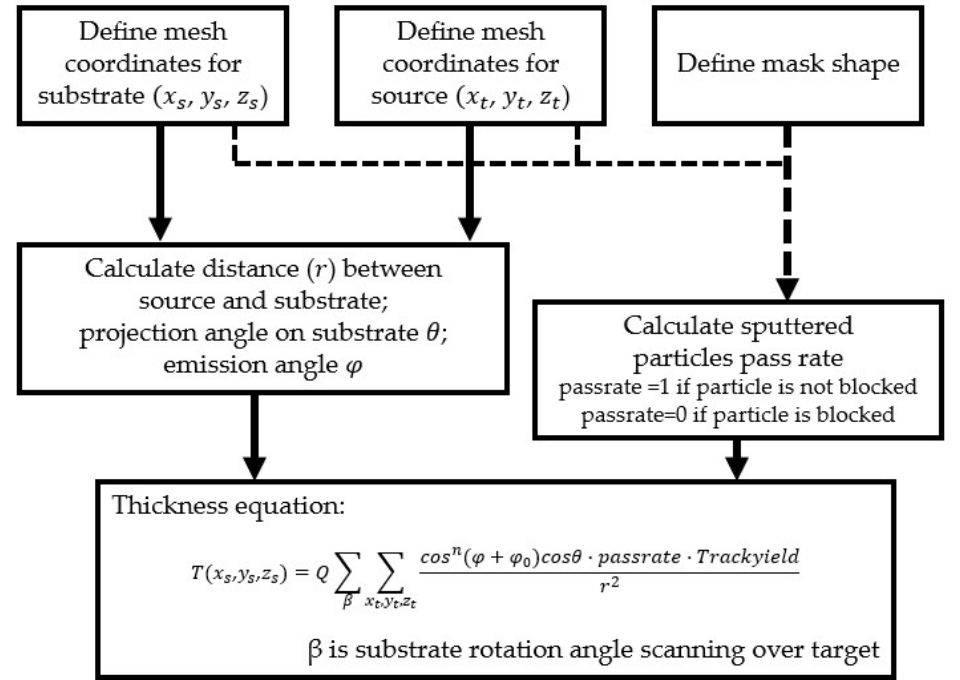
Figure 26. Flow chart for simulation of thickness distribution from sputtering deposition; passrate is a binary, 0 or 1; trackyield is the sputtering yield of the target.